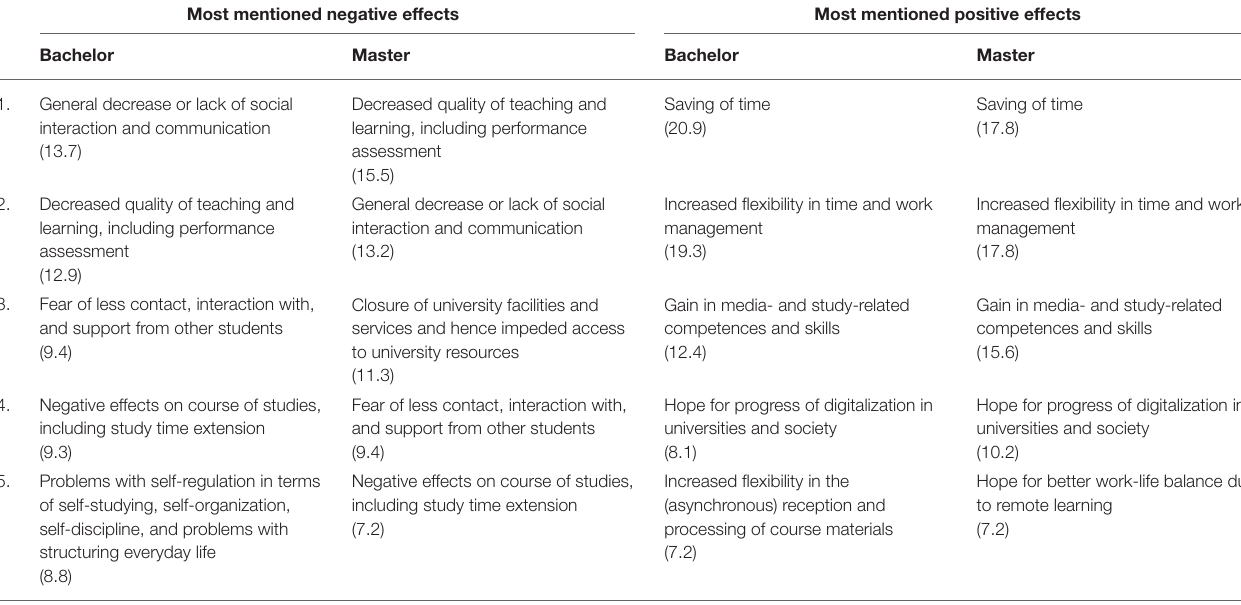
TABLE 3 | Comparison of bachelor and master students’ five most mentioned categories for negative and positive